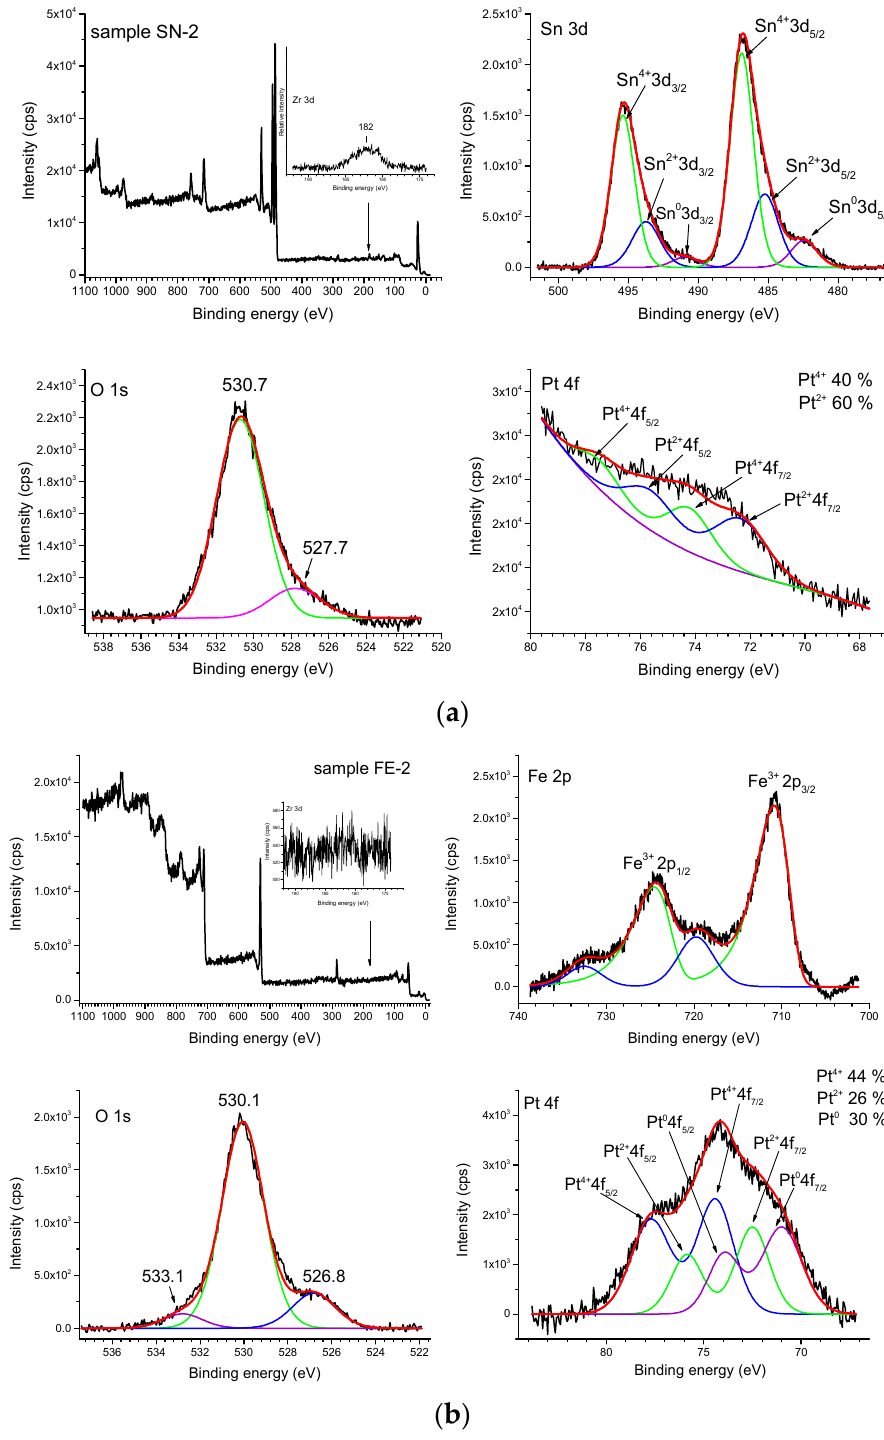
Figure 11. XPS spectra of samples SN-2, panel ( a ) and sample FE-2, panel ( b ). Figure 11, panel (b) shows the high-resolution Fe 2p spectrum. The two distinct peaks at binding energies of 710.8 eV for Fe 2p 3/2 and 724.7 eV for 2p 1/2 are consistent with Fe 3+ in α -Fe 2 O 3 [26]. In addition, two satellite peaks characteristic of α -Fe 2 O 3 at 719.8 eV and 732.5 eV are clearly visible [22,25]. The O 1s peak consists of three deconvoluted peaks at 526.8, 530.1, and 533.1 eV (Table 1). The binding energy of O1s at 530.1 eV can be associated with O 2- lattice oxygen species, while the peaks at 526.8 eV are most likely related to surface defects (highly oxidative oxygen species O (cid:2870) (cid:2870)(cid:2879) , O − associated with oxygen vacancies, Fe-O- Pt surface bonds, etc.). The peak at 533.1 eV can be attributed to adsorbed oxygen species (e.g., hydroxyl groups -OH, water molecules H 2 O and/or surface-adsorbed oxygen O 2 ). The binding energies of Pt 4f 7/2 and Pt 4f 5/2 were fitted to Pt 0 (70.9 and 73.9 eV), Pt2+ (72.5 and 75.9 eV) and Pt 4+ (74.4 and 77.9 eV). The percentage of Pt 0 , Pt 2+ and Pt 4+ was 30, 26 and 44%, respectively.